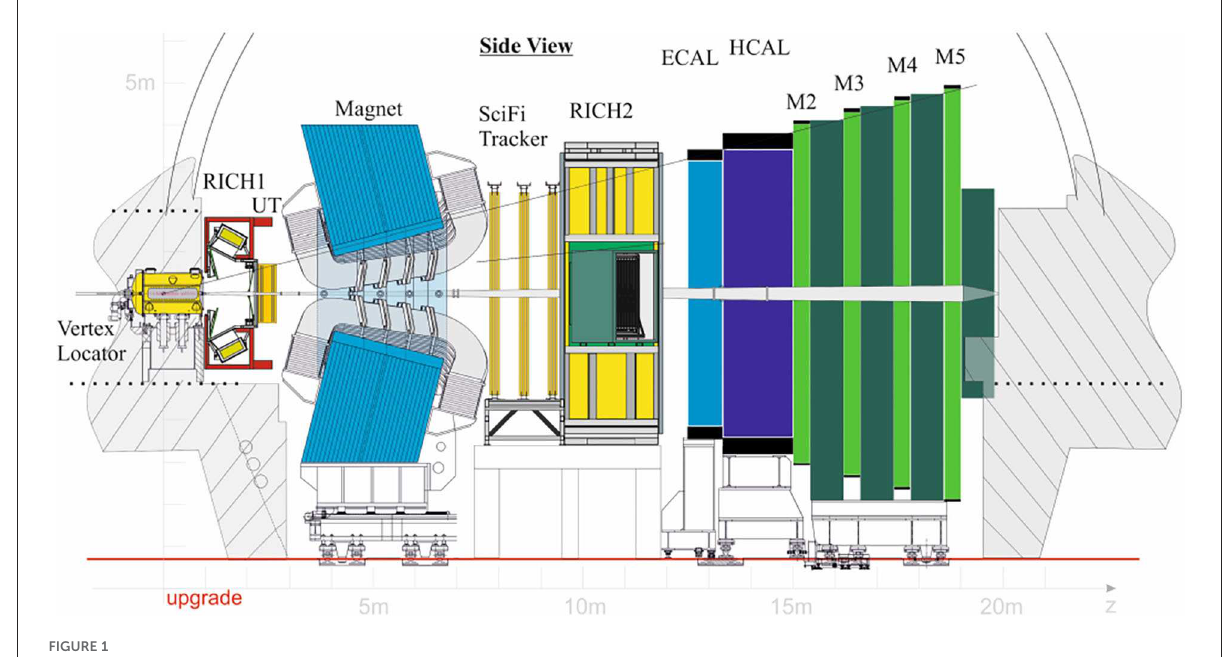
FIGURE1 Sketch of the new LHCb